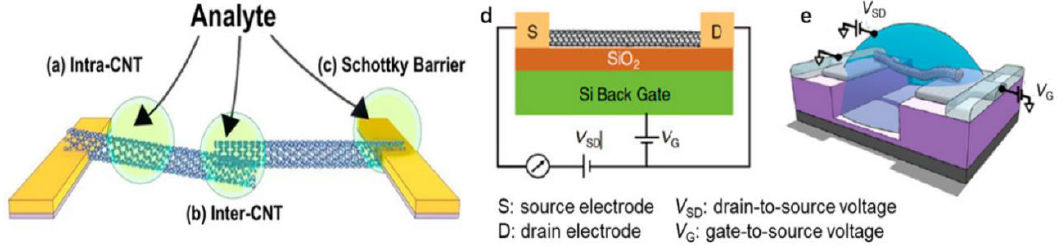
Figure 4. A schematic diagram of the sensitive sites that may affect conductivity ( a – c ), a schematic diagram of carbon nanotube field-effect transistors for sensing: ( a ) at the side wall or along the length of the CNT itself, ( b ) the interface between the CNT and CNT (between the CNT) and ( c ) the interface metal electrode and the CNT (Schottky barrier) between the CNT. Repro- duced from Moghaddam et al. [96] by permission of the American Chemical Society; ( d ) General gated CNT—FET. Reproduced from Sharf et al. [98] by permission of the American Chemical